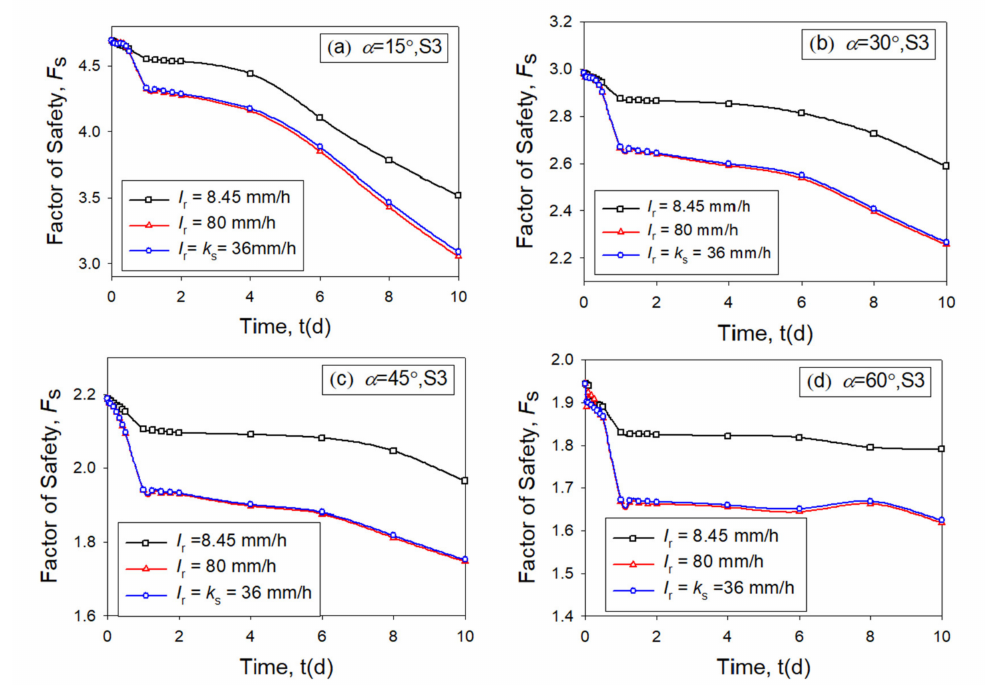
Figure 6. Variation diagram of F s of soil S3 for the slope with different slope angles, ( a ) α = 15 ◦ ; ( b ) α = 30 ◦ ; ( c ) α = 45 ◦ ; ( d ) α = 60 ◦